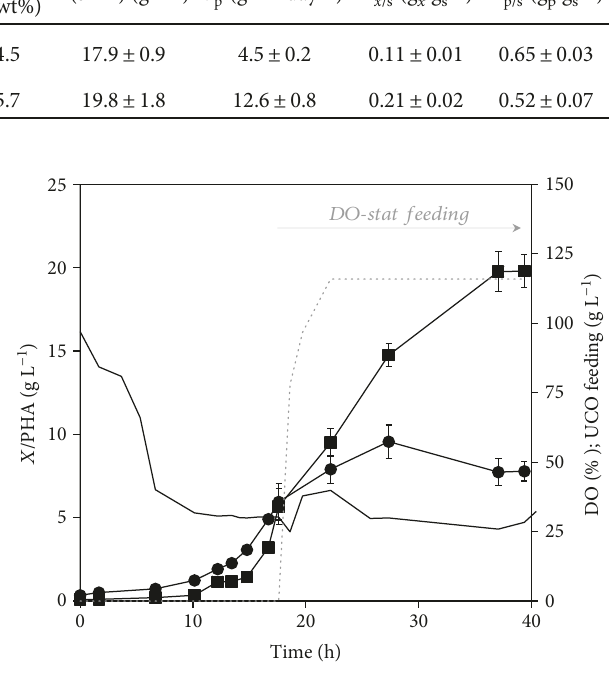
Figure 2: Production of PHA ( ■ ) and active biomass ( ● ) production by C. necator cultivated under DO-stat mode (experiment B), in which UCO was automatically fed ( … .) as a function of the DO concentration ( ____ ) that was kept at 30% air